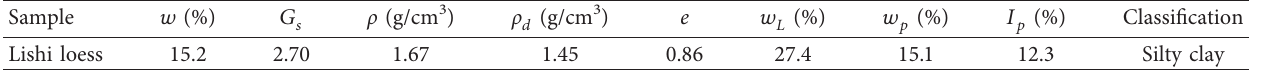
Table 1: Physical parameters of undisturbed loess.